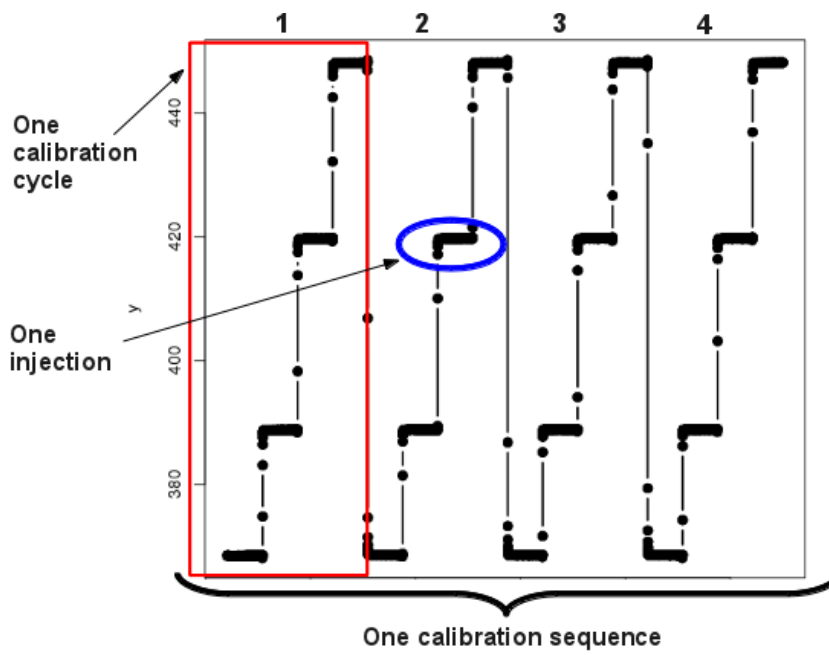
Figure A4. Schematics of the calibration procedure at the MLab. With a measurement interval time of 20–30min, a full sequence lasts between 5 and